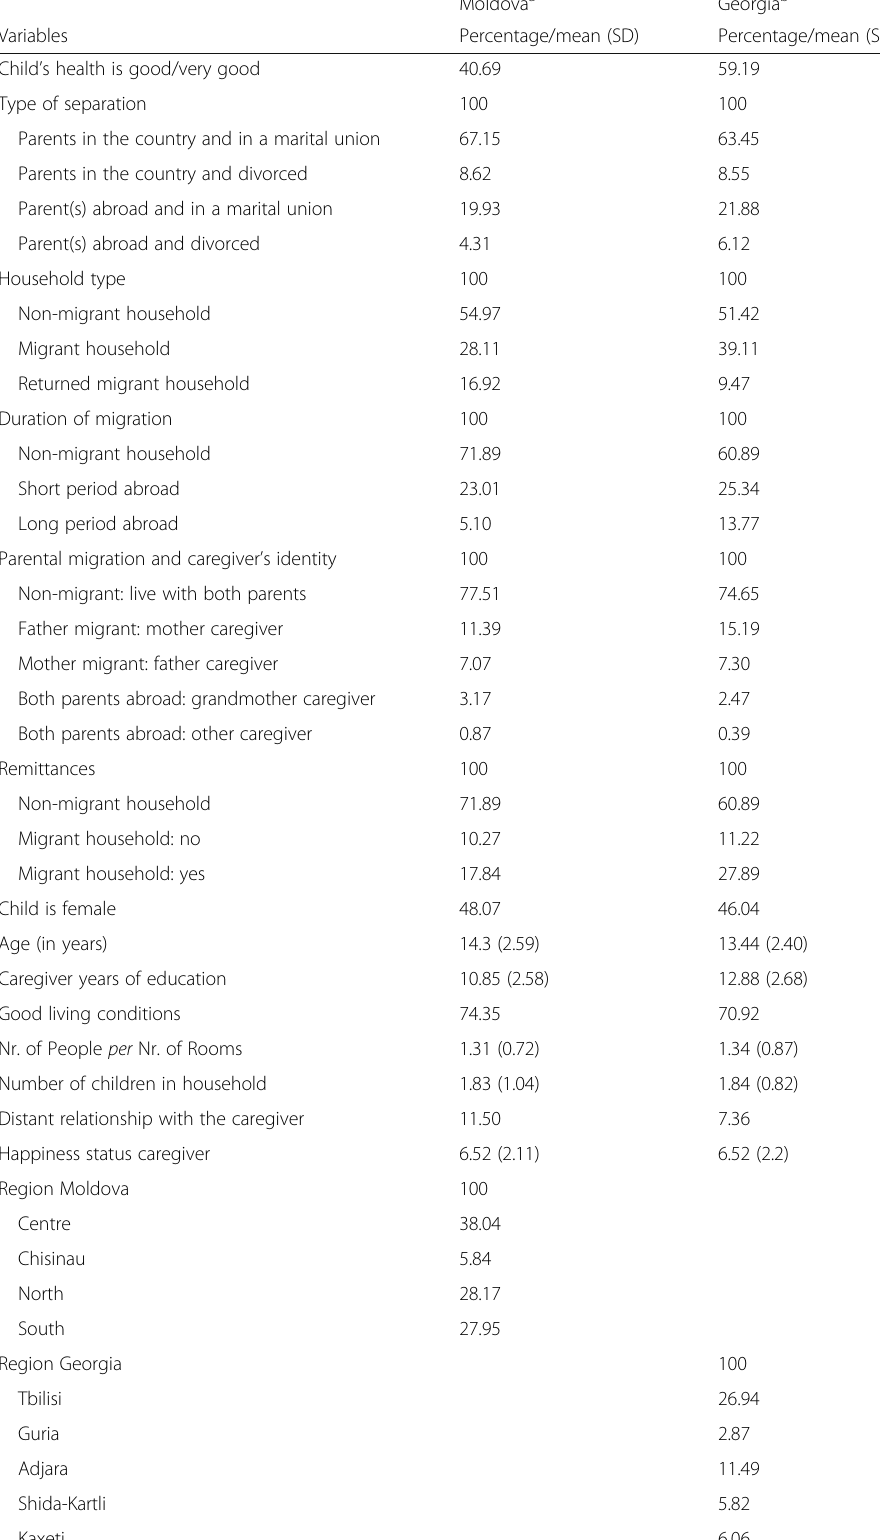
Table 1 Means/percentages (Standard Deviations) of dependent and independent